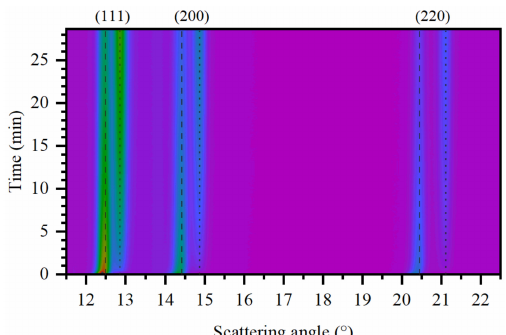
Figure 4. Evolution of in situ XRPD data collected with 0.505235 Å radiation during H 2 desorption at 80 ◦ C after fast outgassing from 2.1 bar hydrogen to vacuum. Vertical dashed and dotted lines highlight the positions of Pd reflections for α - and β -hydride phases respectively. Selected patterns from these series are shown in Figure S2 of the Supporting Information.